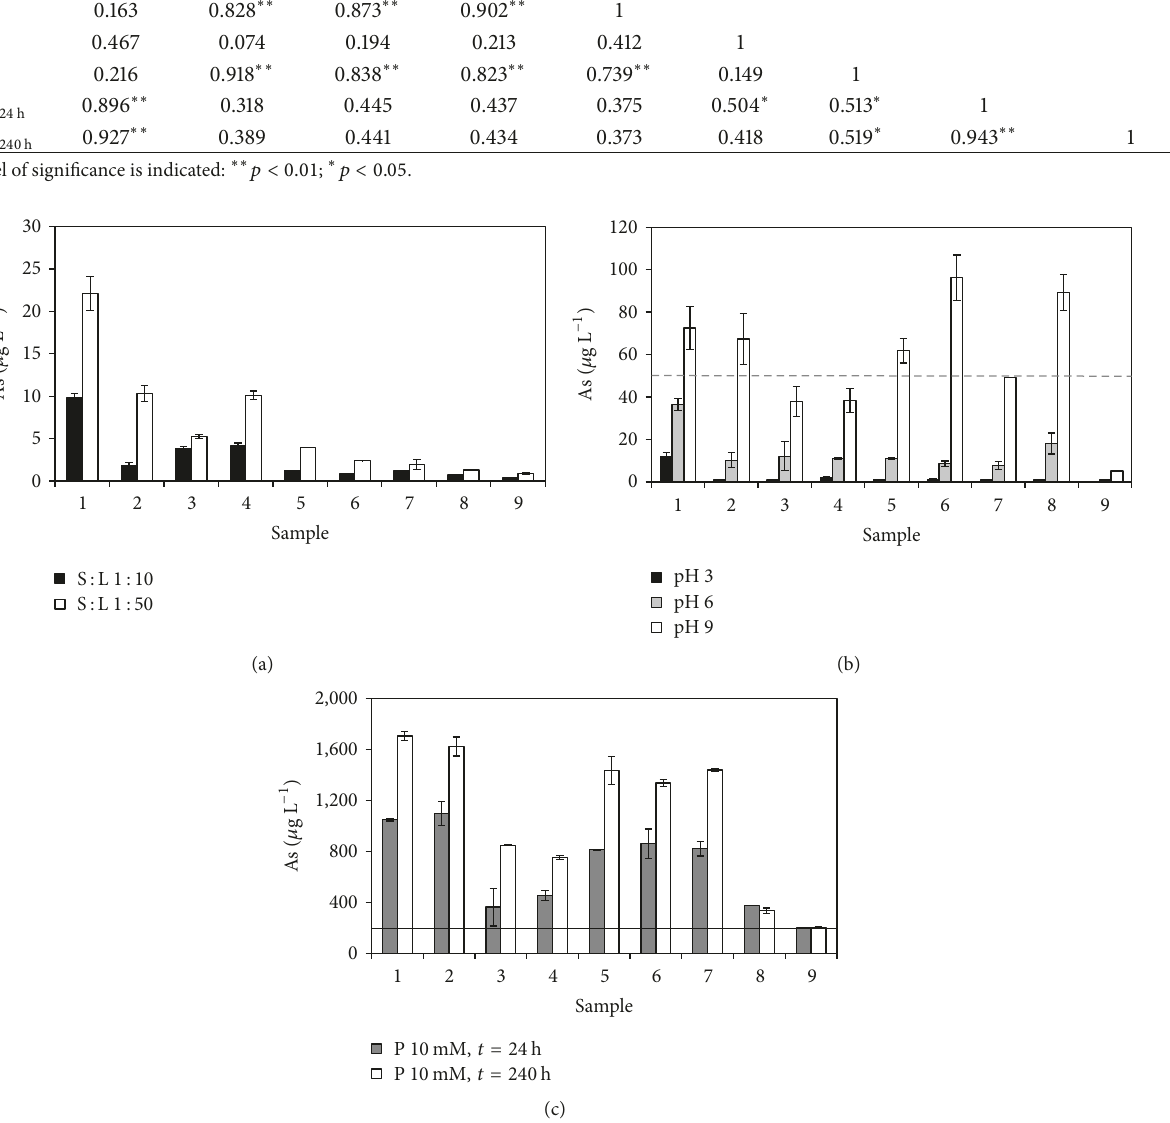
Figure 5: (a) Effect of solid :liquid ratio (1:10 and 1: 50). (b) Effect of pH (3, 6, and 9). Solid: liquid ratio 1:10, 0.01M NaNO3, 𝑡 = 24 h. (c) Effect of P and time (24 and 240 h). The grey dashed and the solid black lines indicate the leaching limit values for waste acceptable in landfills for inert and nonhazardous waste, respectively (EC